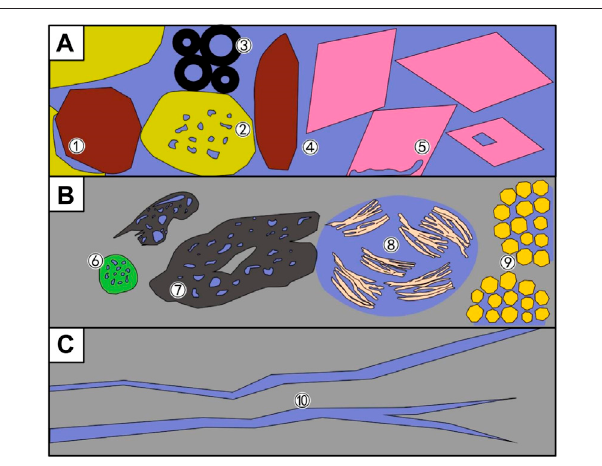
FIGURE 2 | Key components of shale microstructure and their relationshipswithpores. (A) Grainlaminae:(1)poresattheedgeofrigidgrains, (2) moldic pores, (3) pores within fossil bodies, (4) pores between grains and crystals, and (5) dissolution-rim pores; (B) Organic-matter aggregates: (6) pores within peloids or pellets, (7) organic-matter pores, (8) pores between or within clay platelets, and (9) intercrystalline pores within pyrite framboids; and (C) (10)